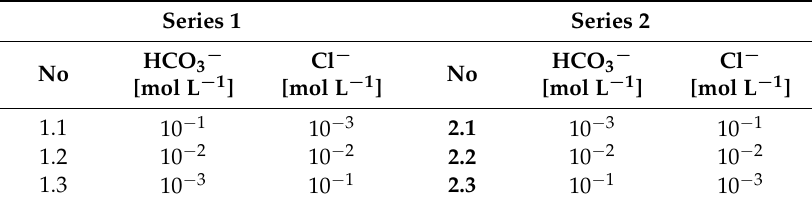
Table 3. Concentrations of ions in calibration solutions.